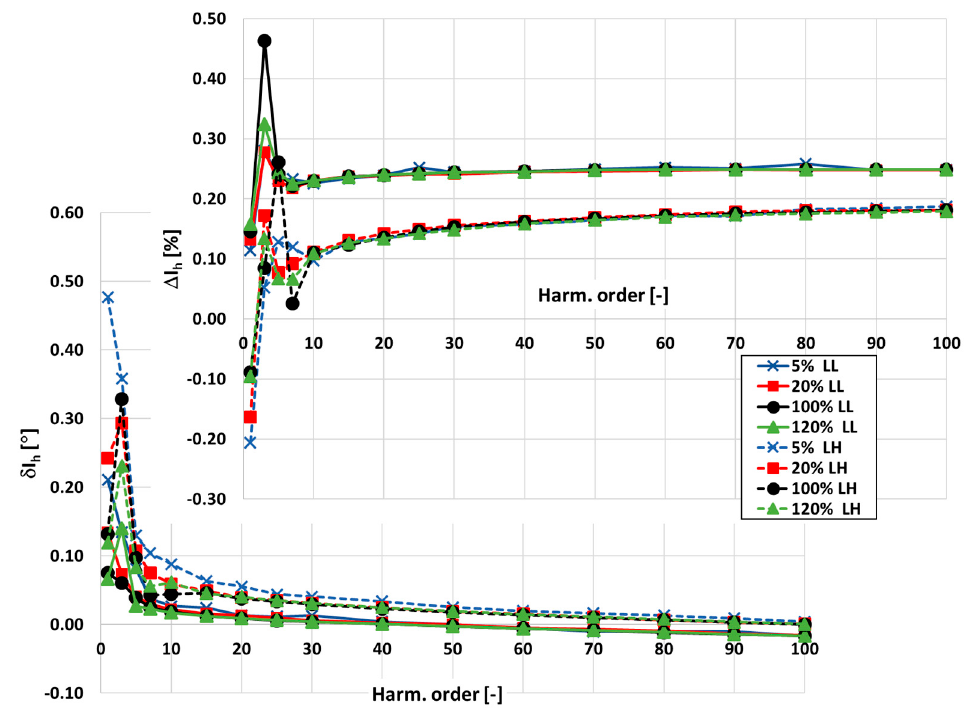
Figure 6. The values of the current and phase errors at harmonics of the 100\1 A inductive CT for 25% and 100% of the rated load of the secondary windings when the distorted primary current was equal to 5%, 20%, 100%, and 120% of its rated value.